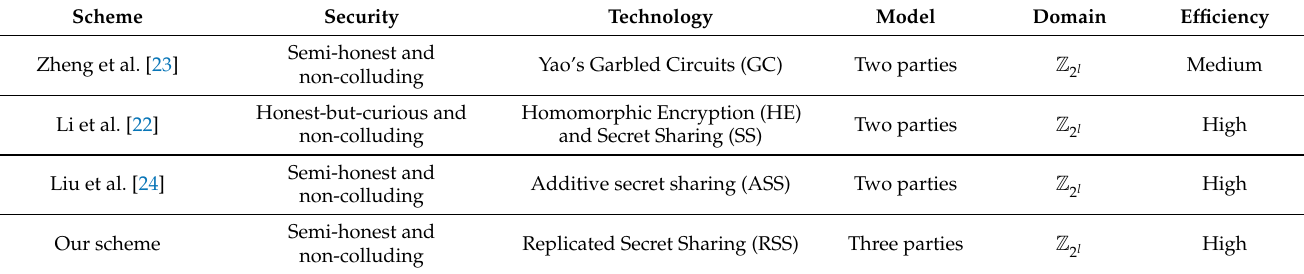
Table 2. The comparison of different privacy-preserving outsourcing convolutional neural net- work